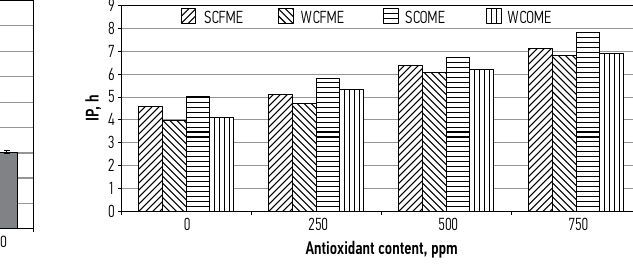
Fig. 3. The dependence of the induction period on the concentration of antioxidant